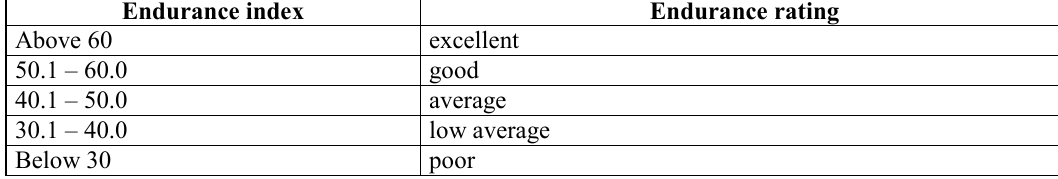
Physical fitness criteria developed by Mazur et al.